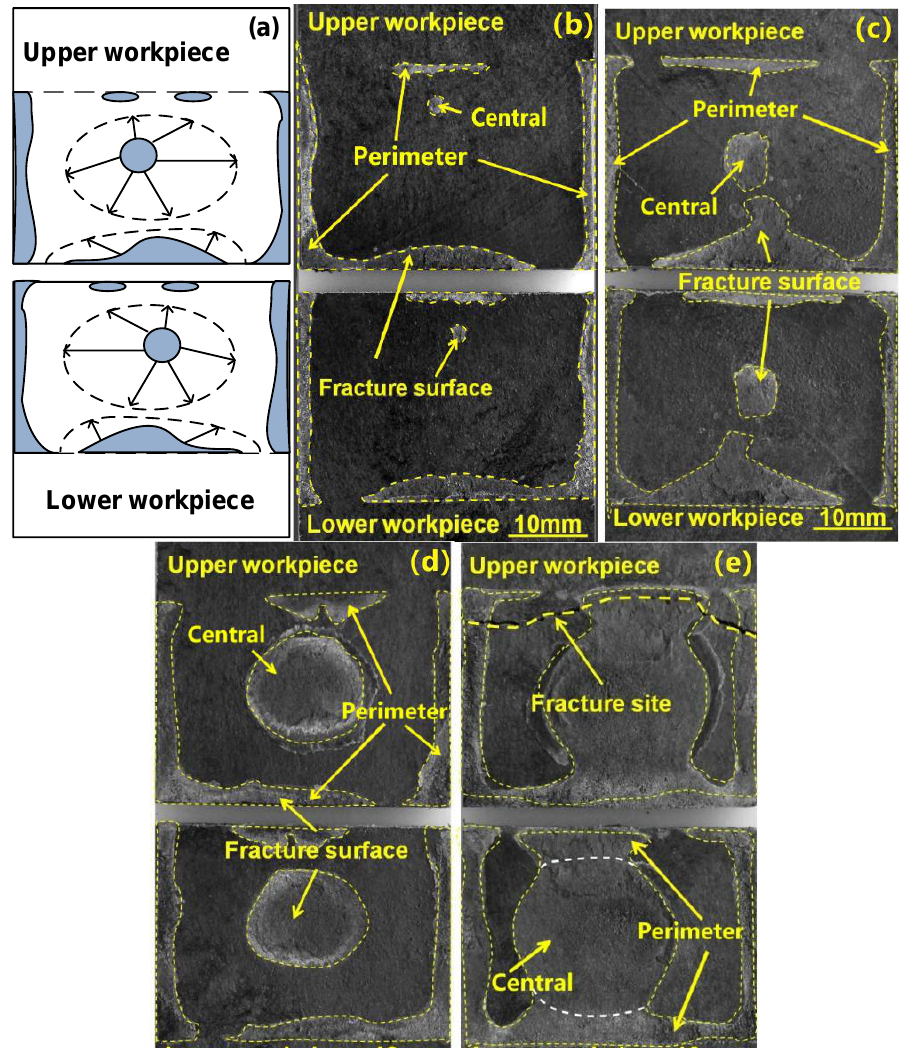
Figure 9. Schematic of weld growth with normal clamps ( a ), and weld appearance at various weld- ing times of ( b ) 0.5 s, ( c ) 0.9 s, ( d ) 1.3 s, ( e ) 2.1 s. times of ( b ) 0.5 s, ( c ) 0.9 s, ( d ) 1.3 s, ( e ) 2.1